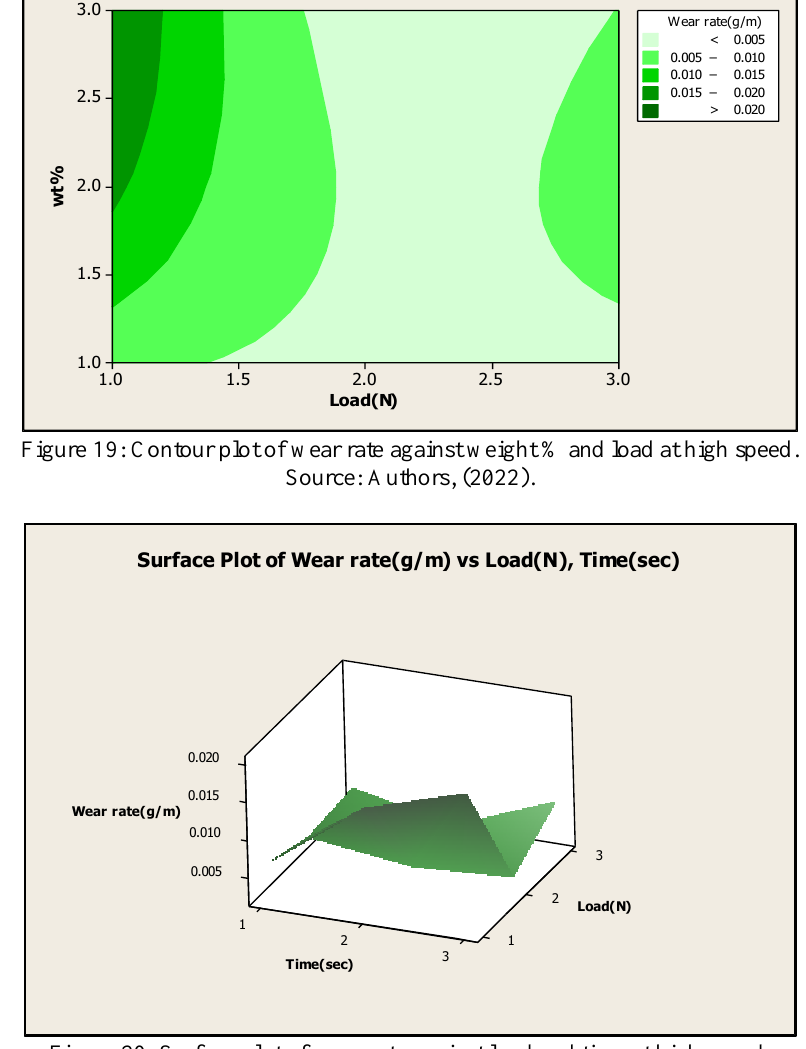
Figure 20: Surface plot of wear rate against load and time at high speed. Source: Authors, (2022).